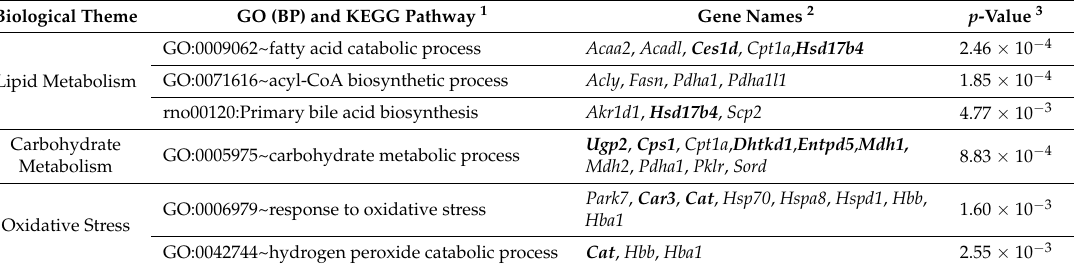
Table 9. Enriched gene ontology biological process terms and KEGG pathways in the list of differentially expressed proteins with Purple Carrots in liver that are involved in lipid metabolism, carbohydrate metabolism and oxidative